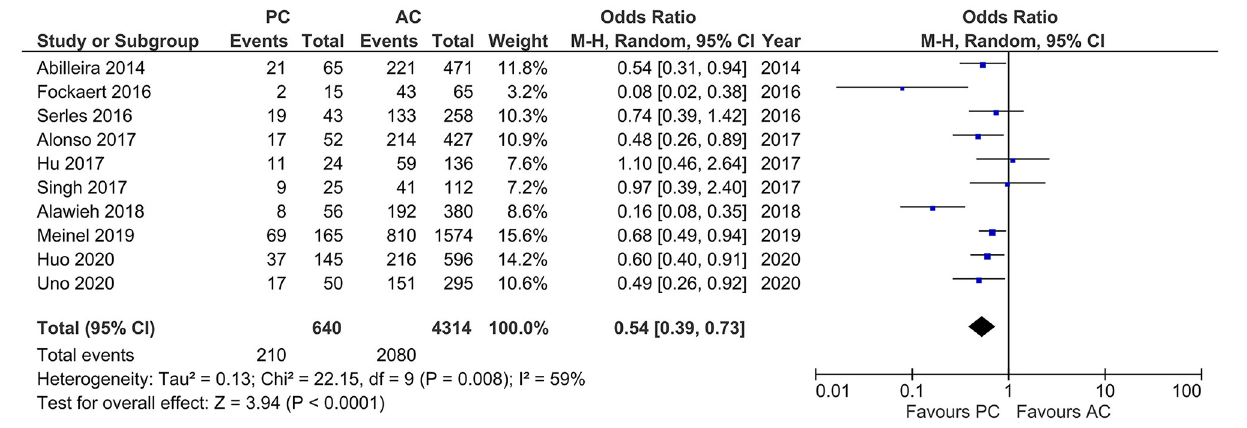
FIGURE 4 | Forest plot comparing “admission NIHSS” of patients with large vessel occlusion in the posterior circulation (PC) vs. anterior circulation (AC) who were treated with endovascular mechanical thrombectomy. Chi 2 , chi-square statistic; CI, confidence interval; df, degrees of freedom; I 2 , I -square heterogeneity statistic; IV, weighted mean difference; P , p -value; SD, standard deviation; Std., standardized; Tau 2 , estimated variance of underlying effects across studies; Z , Z statistic.